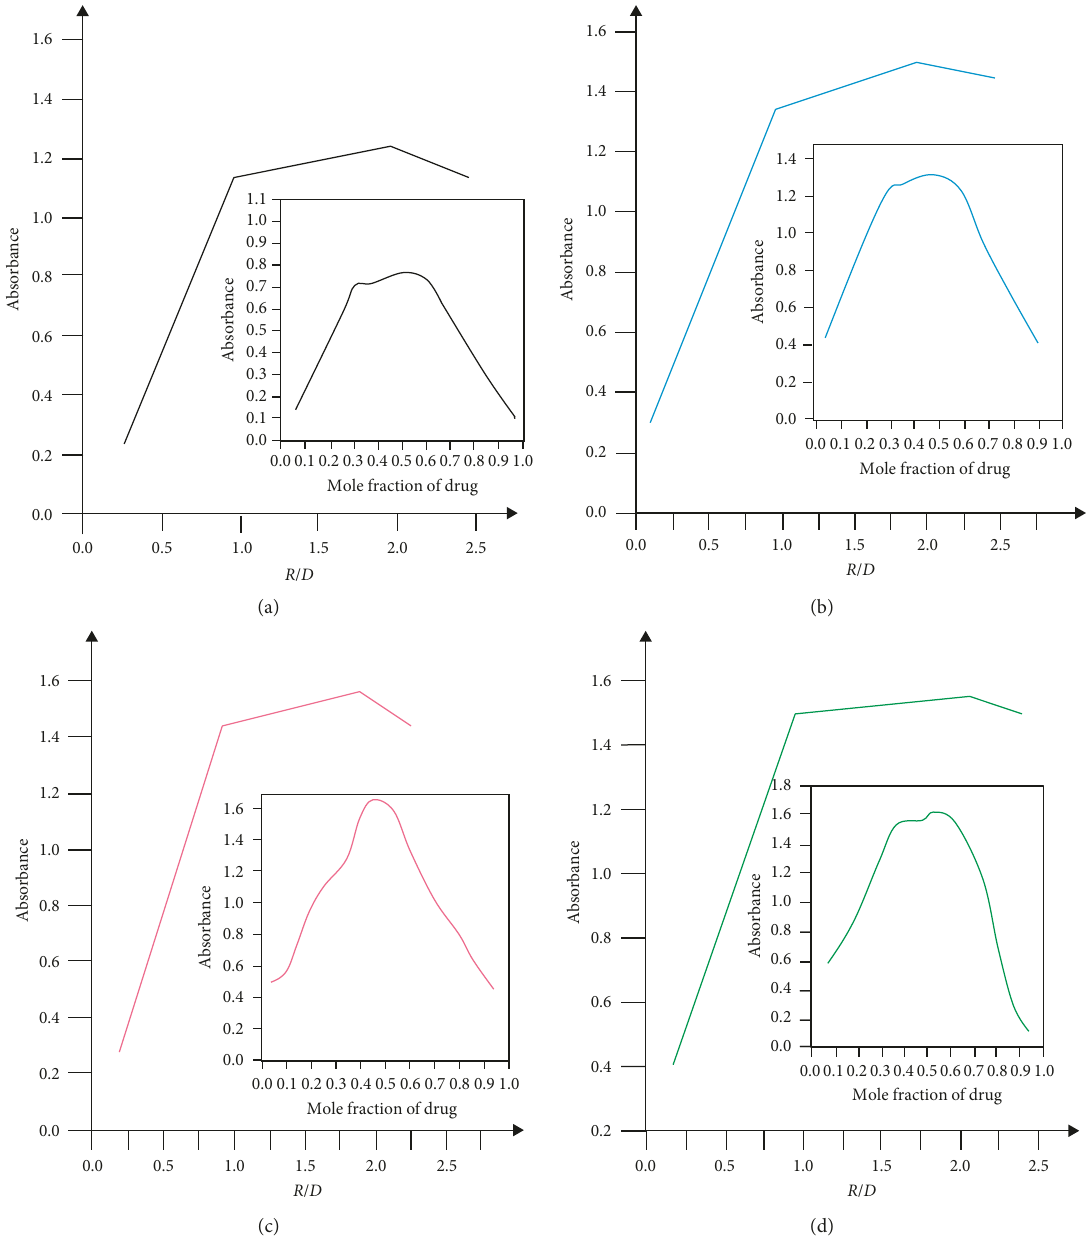
F IGURE 1: Stoichiometry of formed complexes between diaveridine and reagents I (a), II (b), III (c), and IV (d) complexes by MRM and CVM